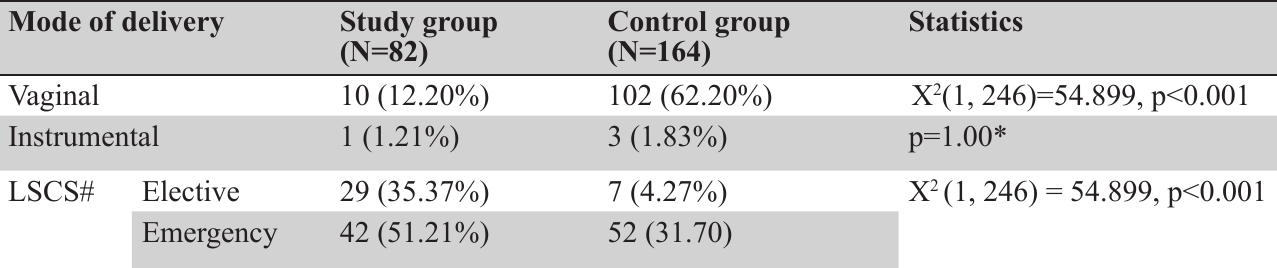
Table 2. Comparison of mode of delivery between the groups.